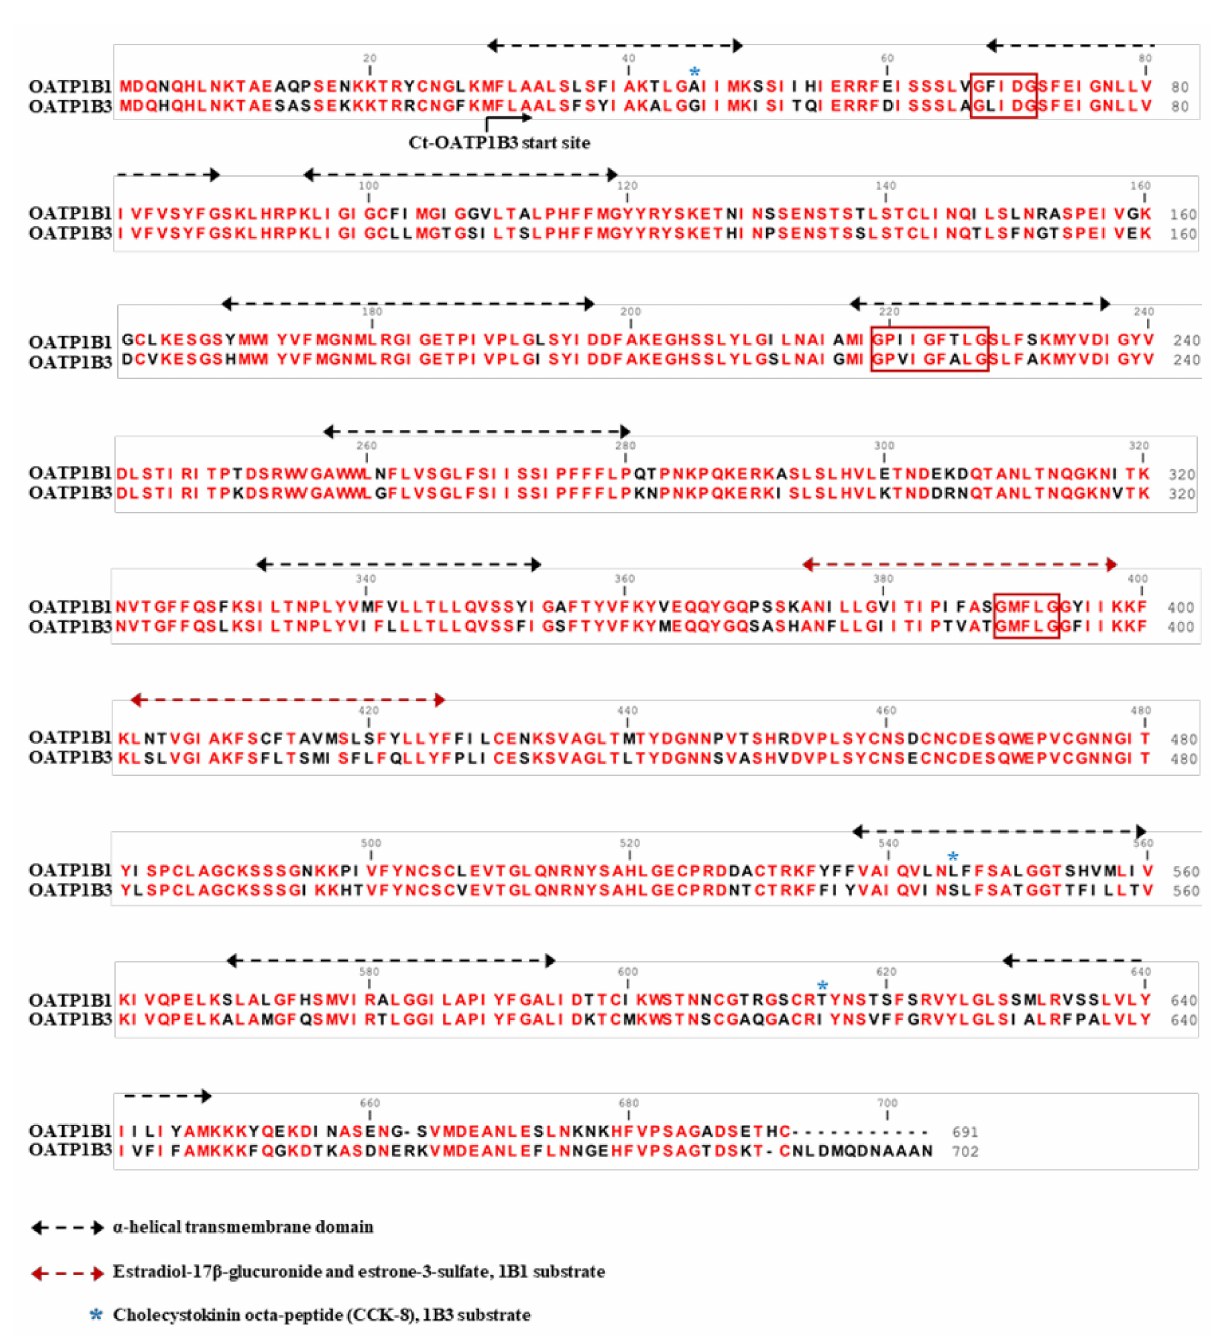
Figure 1. Sequence alignment of human OATP1B1 and OATP1B3. Twelve putative transmembrane domains are under the black dotted lines. The specific domains critical for transport specificity are under the red dotted lines. The amino acid residues the are presumably important for CCK-8 are labeled with a blue star. The conserved amino acid residues between OATP1B1 and OATP1B3 are in red. Three GxxxG motifs associated with oligomerization are boxed in